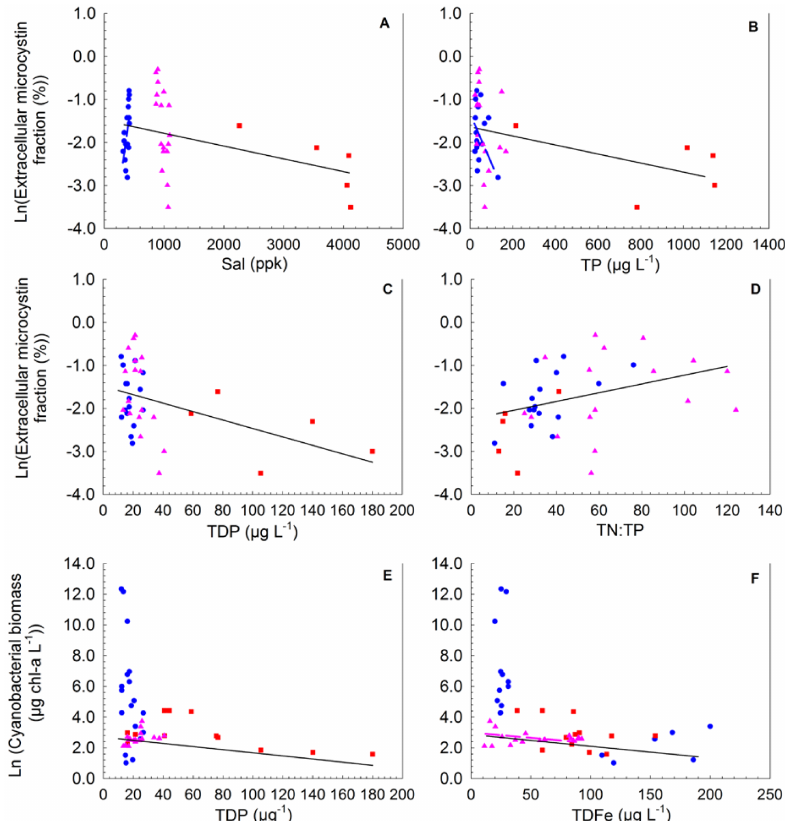
Figure 8. The correlations between extracellular microcystin fraction and (a) Sal, (b) TP, (c) TDP, (d) TN:TP, and between cyanobacterial biomass and (e) TDP, (f) TDFe in Jackadder, Bibra and Yangebup lakes during the study period. Regression curves for each individual lake were calculated by linear mixed models with site and date as random factors on data from each lake (broken lines) while all data points were combined for the overall regression using a linear mixed model adding lake as random factor (solid line). All regression shown are p < 0.05, except for the regression calculated for all lakes combined in (a) , which is p < 0.1. Symbols and lines are explained in Fig. 6. Table 3. Pearson’s correlation coefficients ( R ) between the environmental variables and cellular microcystin concentration (µgg − 1 ) or extracellular microcystin fraction (%) analysed for each lake and for all lakes combined using bivariate correlation analysis. The dependent variables are ln transformed. Extracellular microcystin fraction was zero in seven cases, leading to an N = 5 only.